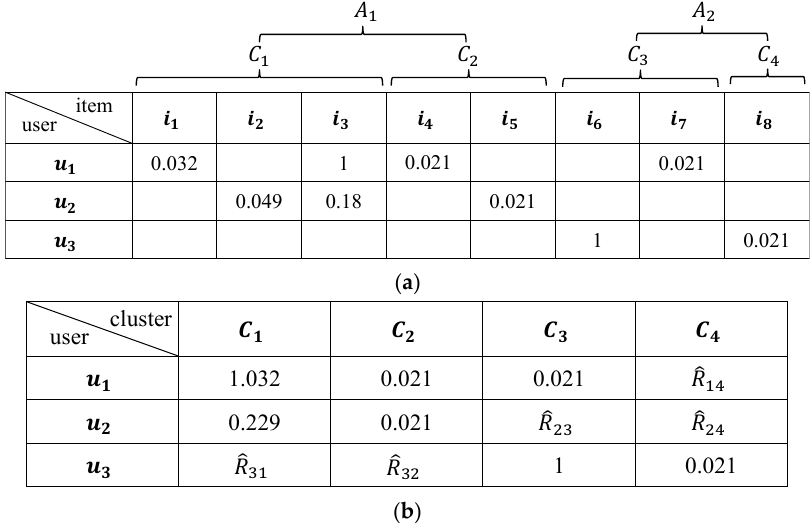
Figure 3. Construction of user–cluster ratings matrix. ( a ) Before merging. ( b ) After merging.